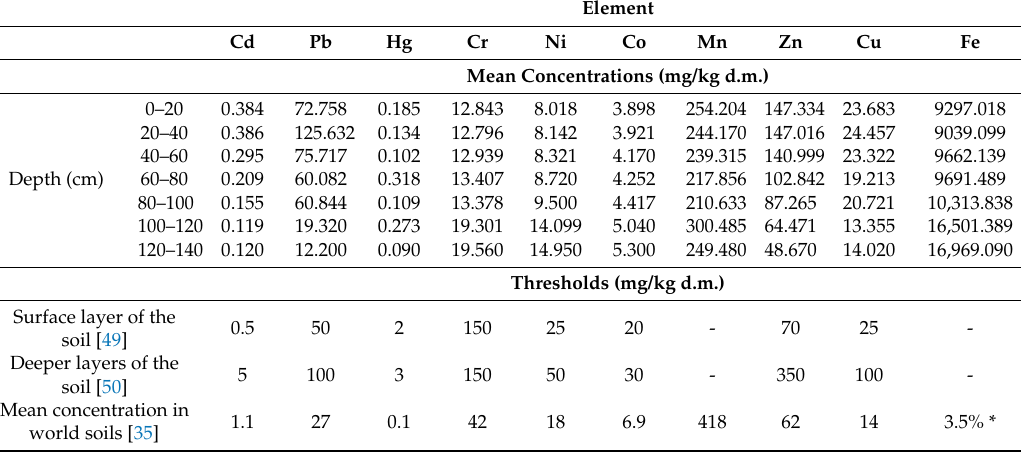
Table 2. Concentration of the tested elements (mg/kg d.m.) depending on the depth of sampling and limits and global average concentrations (mg/kg d.m.) of selected elements in the soil. Lead (Pb), chromium (Cr), copper (Cu), zinc (Zn), iron (Fe), manganese (Mn), and nickel (Ni) were determined by flame absorption spectrometry (FAAS) in an acetylene-air flame, while mercury (Hg) was determined by cold vapor using a UNICAM 939 Solaar spectrometer. Cadmium (Cd) and cobalt (Co) were determined by graphite furnace atomic absorption spectroscopy (GFAAS) and a PerkinElmer 4100ZL spectrometer equipped with a Zeeman background correction